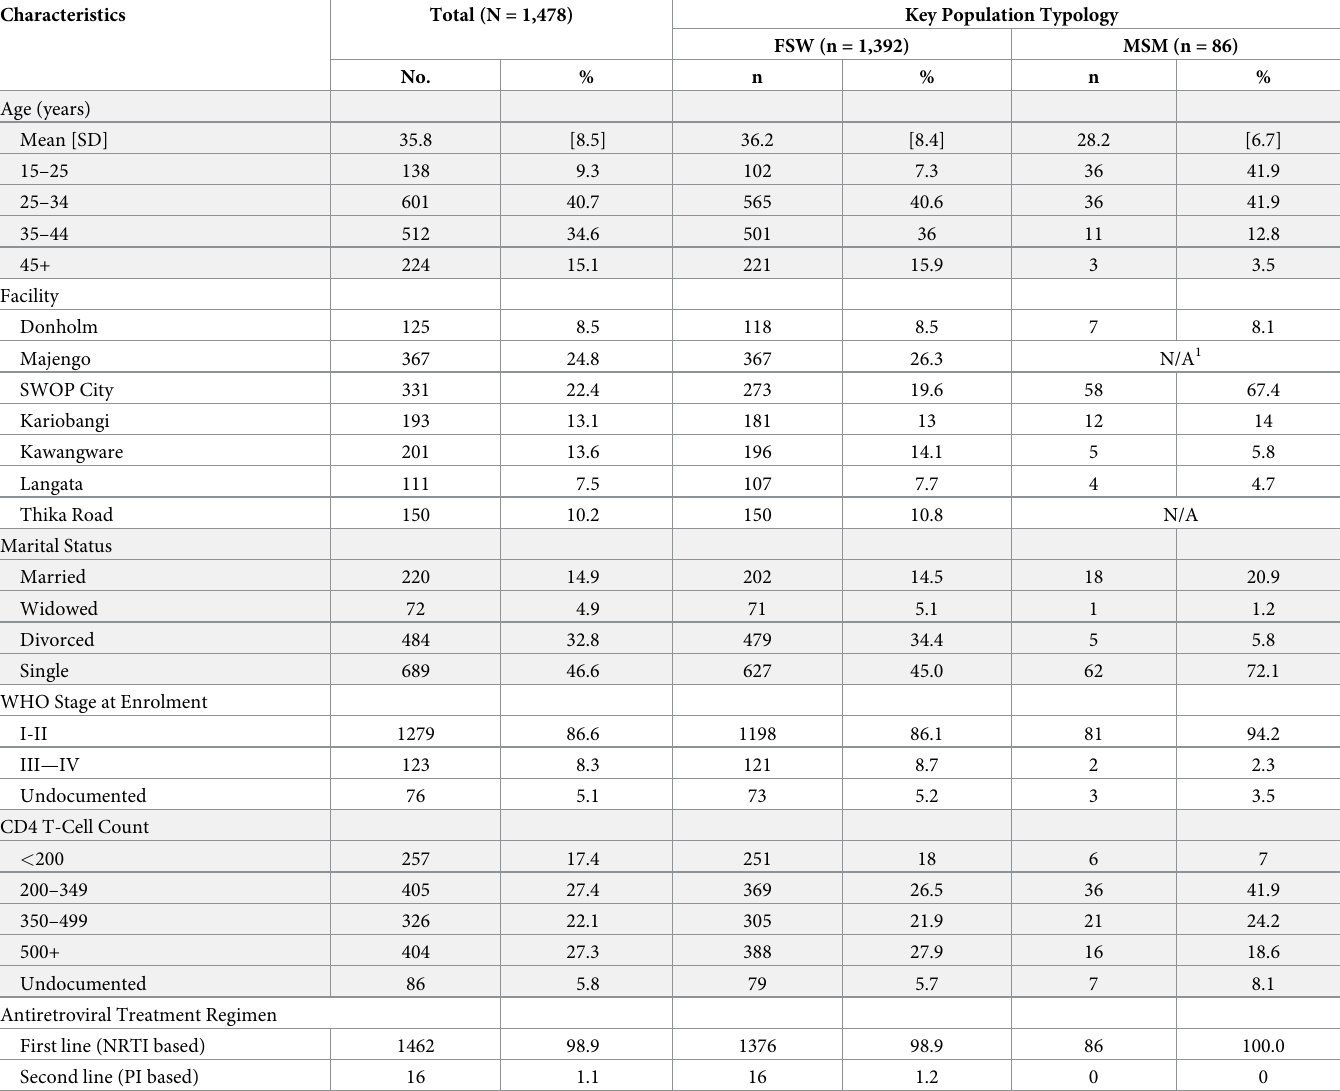
Table 1. Baseline characteristics of key populations living with HIV attending SWOP clinics by typology, 2012–2015 (N = 1,478).